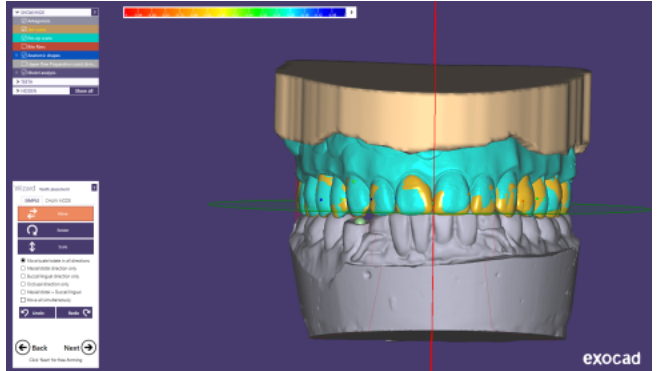
Figure 17. Defining a new tissue surface and correcting the position of the teeth. The color contrast indicates the old and the new digital outline overlapping each other (DentalCAD 2.4 Plovdiv, exocad ® GmbH, Darmstadt, Germany).